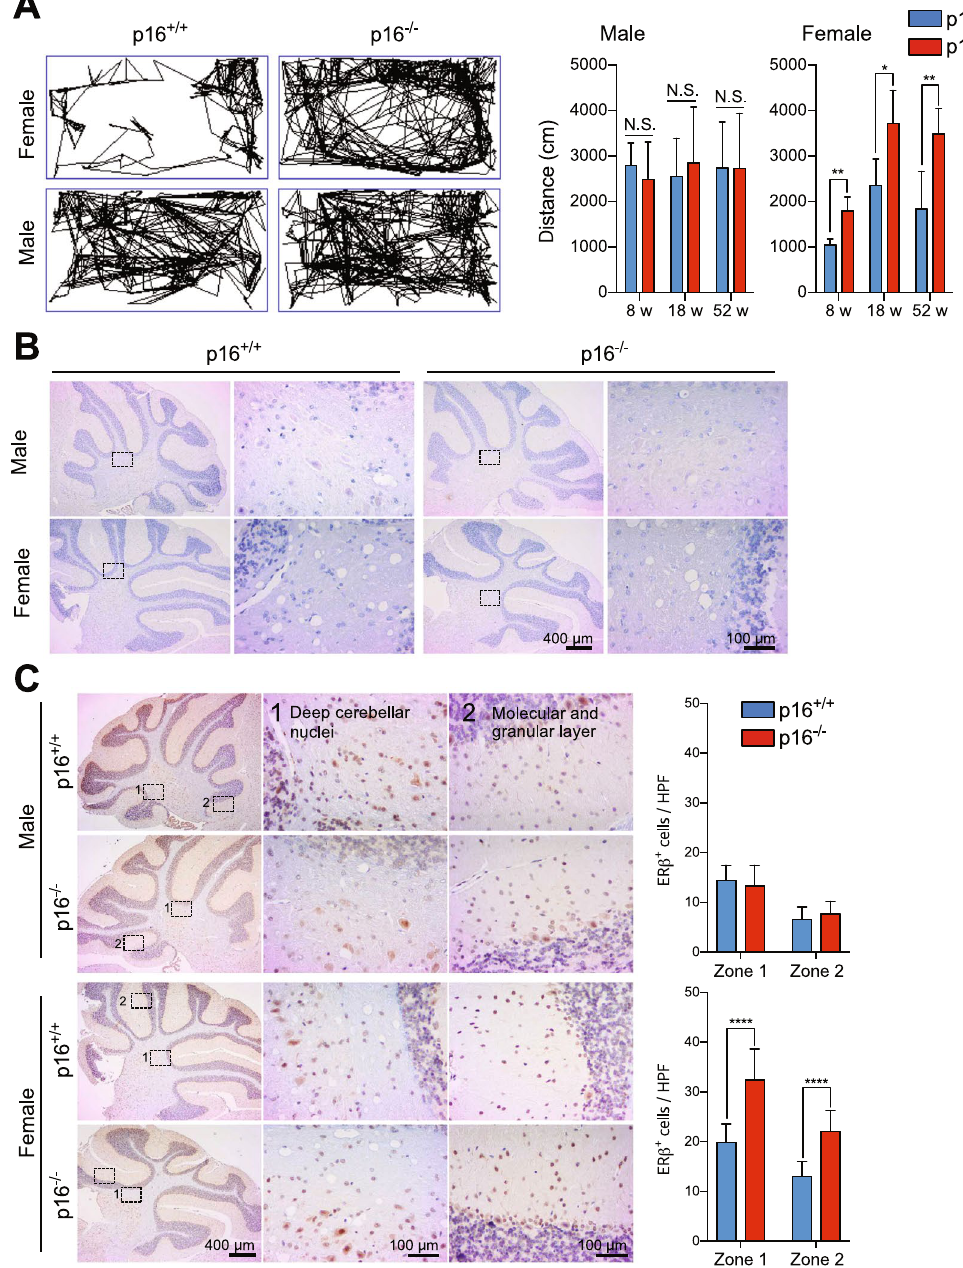
Figure 3. Mouse mobility and distribution of estrogen receptors in the cerebellum. ( A ) Movements of 1 year- old p16 + / + and p16 − / − FVB mice were tracked by video for 3 min in a test cage (left images) and total distances were calculated (right graph) (n = 8). ( B , C ) Cerebellum sections from p16 + / + and p16 − / − FVB male and female mice were stained with anti-ER α ( B) or anti-ER β ( C) and ER β + cells (brown) were quantified (n = 15). HPF, high power field. Results are mean ±